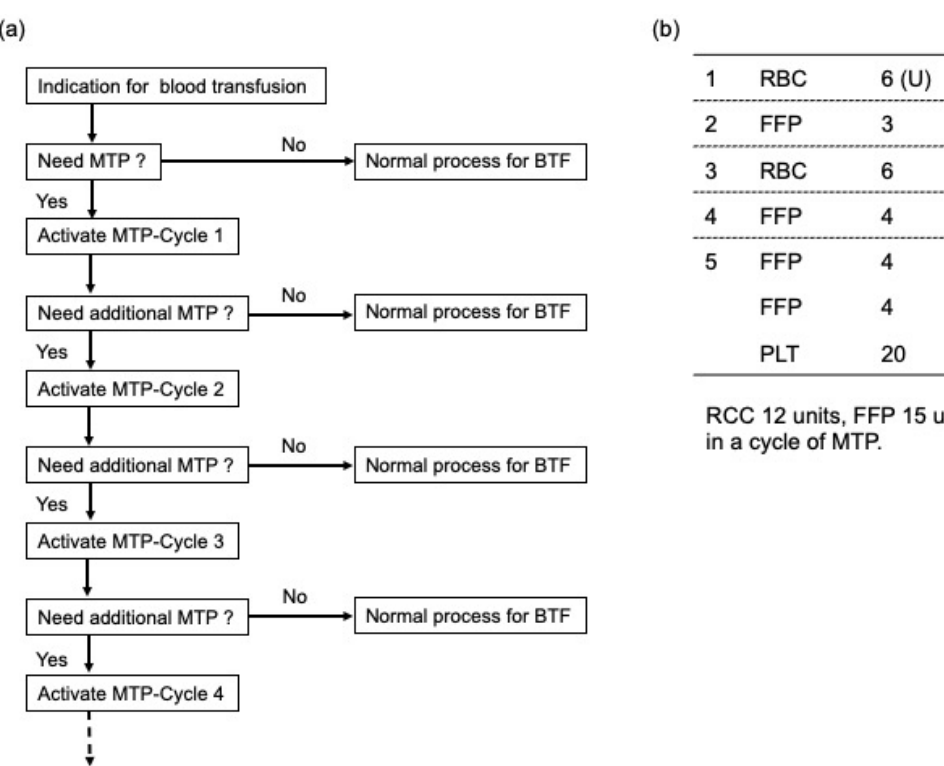
Figure 1. Flow diagram illustrating the massive blood transfusion protocol. ( a ) Flow diagram of massive blood transfusion protocol. ( b ) Blood products in one cycle of massive blood transfusion protocol. MTP, massive blood transfusion protocol; BTF, blood transfusion; RBC, red blood cells; FFP, fresh frozen plasma; PLT, platelet. The amount of RBC, FFP, and PLT transfusions is described by Japanese units, which is defined as that derived from 200 mL whole blood.